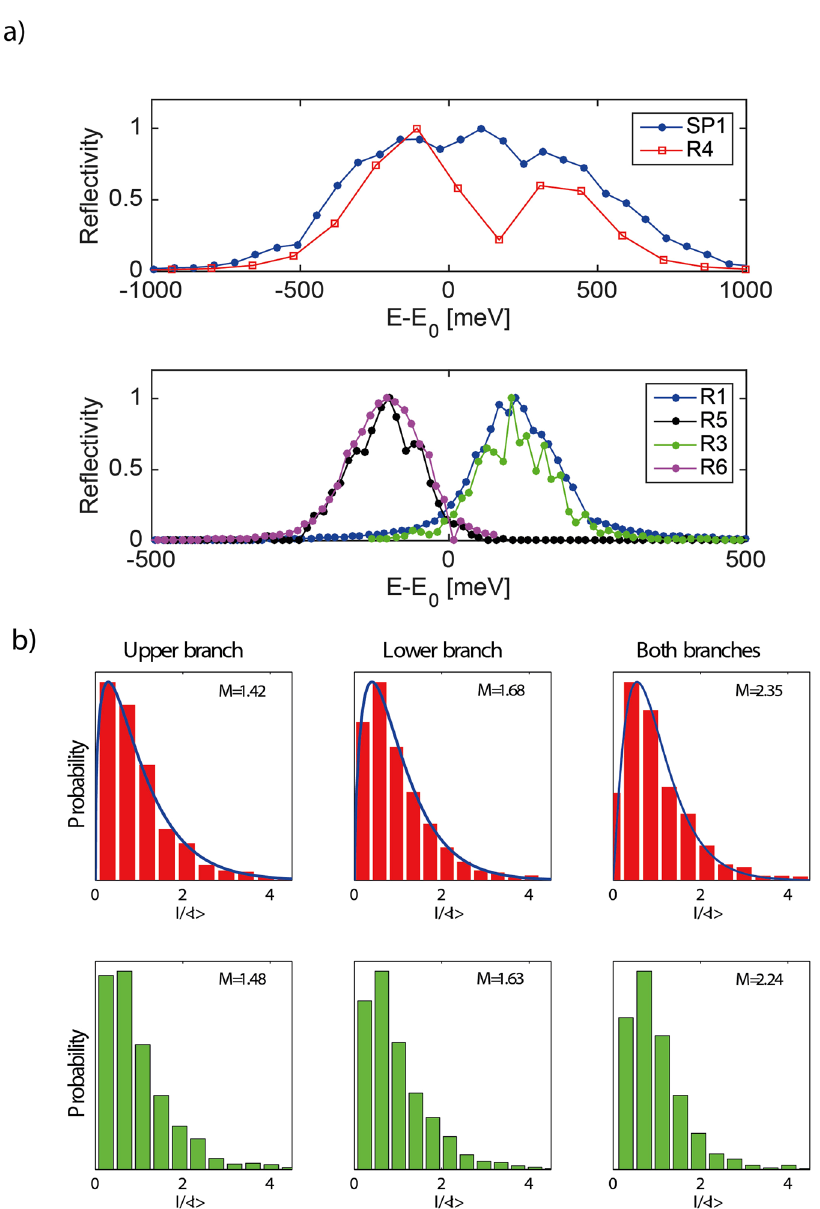
row) Simulation results of the corresponding